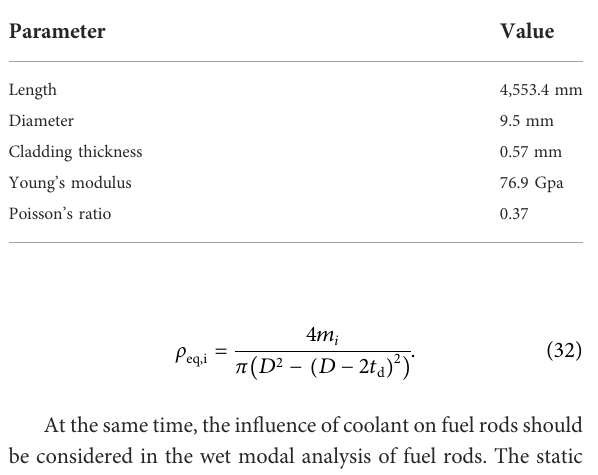
TABLE 1 Physical parameters of EPR fuel rods. TABLE 2 Real constants used by the Beam4